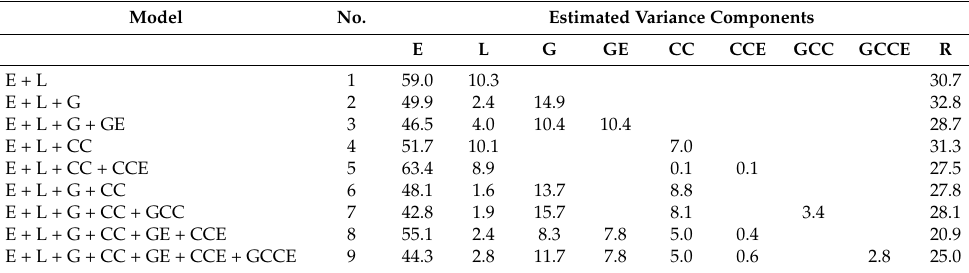
Table 1. Estimated variance components for the nine models for yield.